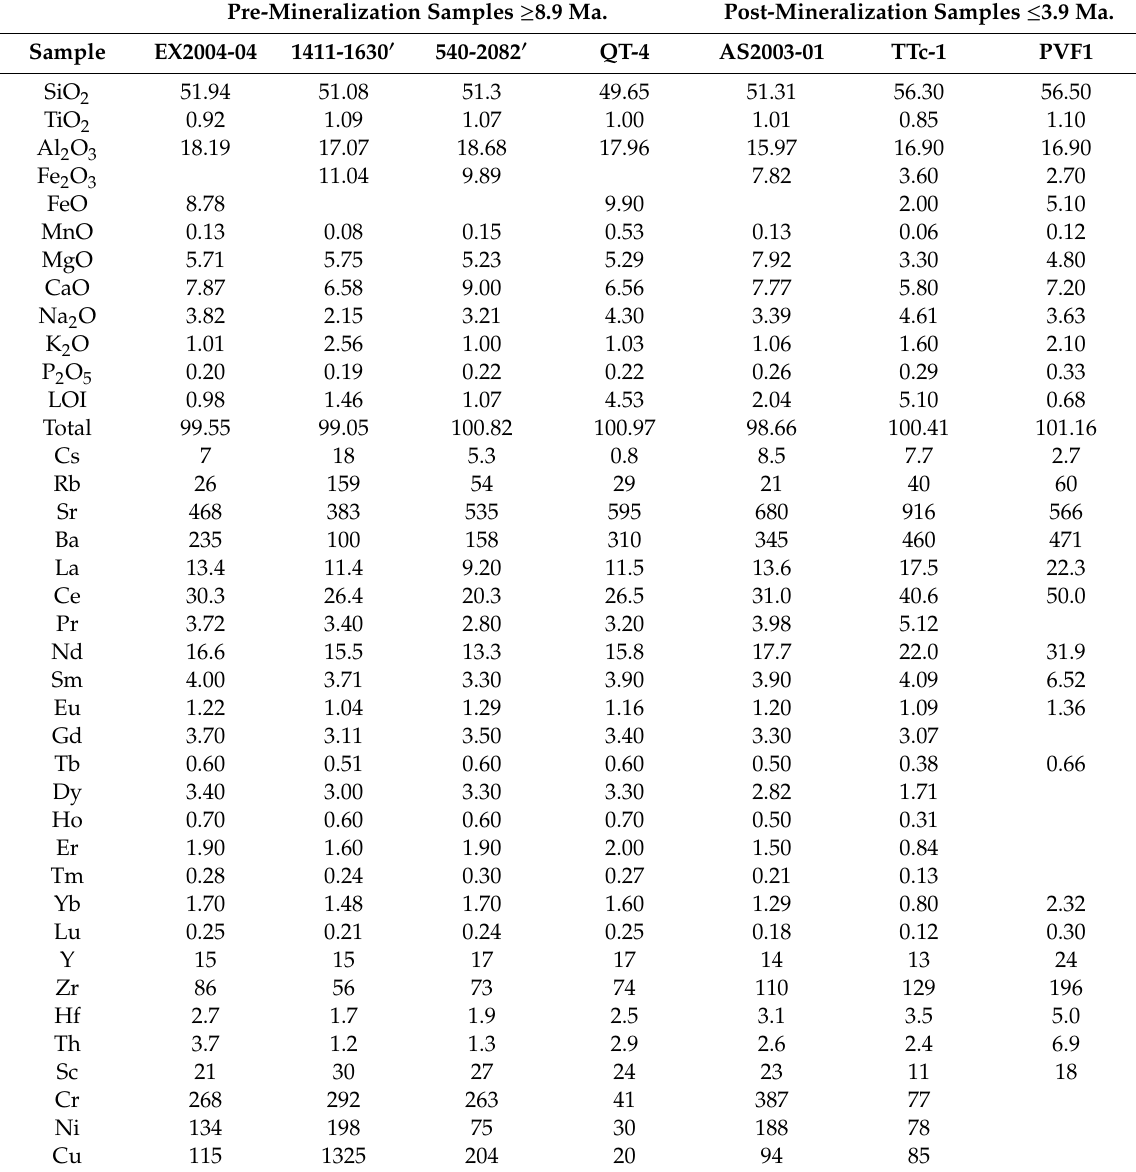
Table 2. Major and trace-element (in ppm) compositions of mafic rocks from El Teniente [21–23]. Pre-Mineralization Samples ≥ 8.9